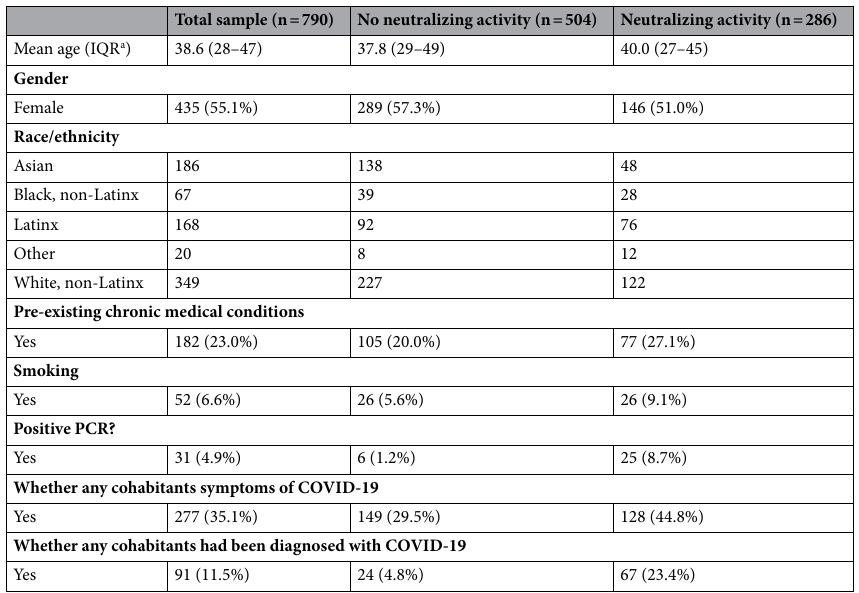
Table 1. Demographic statistics of seropositive sample population. N = 790. a Inter-quartile range.